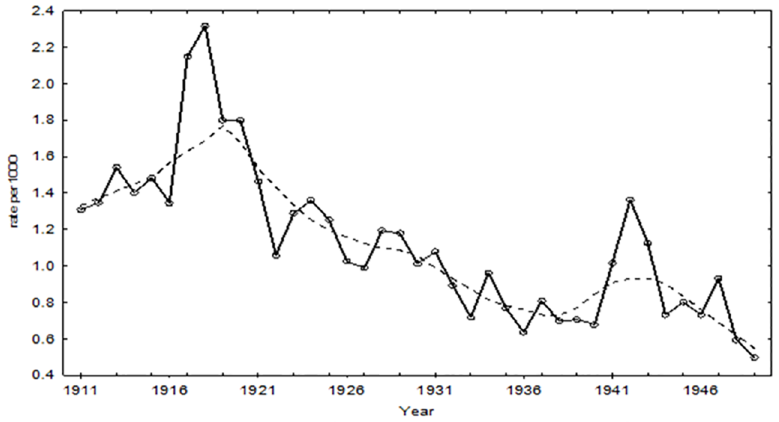
Fig 7. Tuberculosis mortality rate and lowess for reproductively aged individuals: Malta